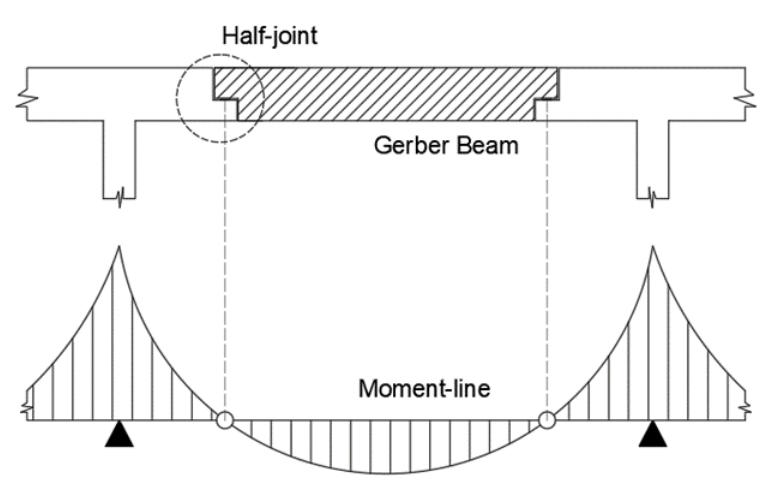
Figure 2. Static scheme of a suspended span and half-joint.